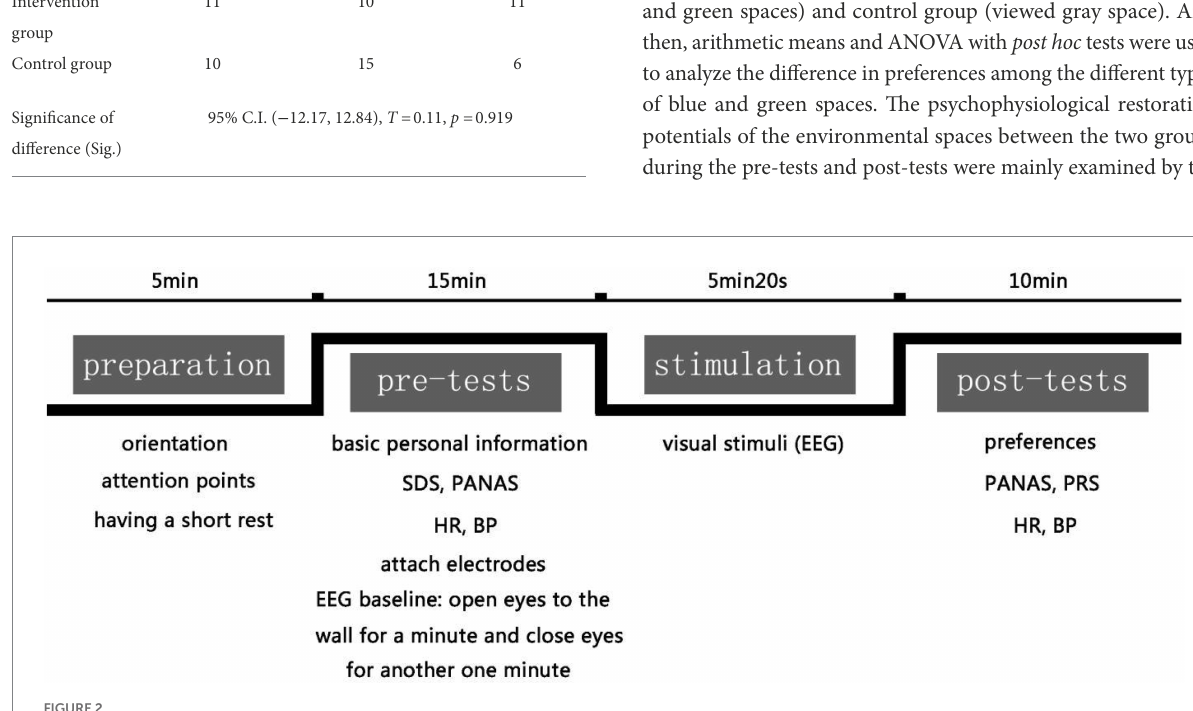
FIGURE 2 The study procedure within one experimental intervention and the corresponding time used within each stage.